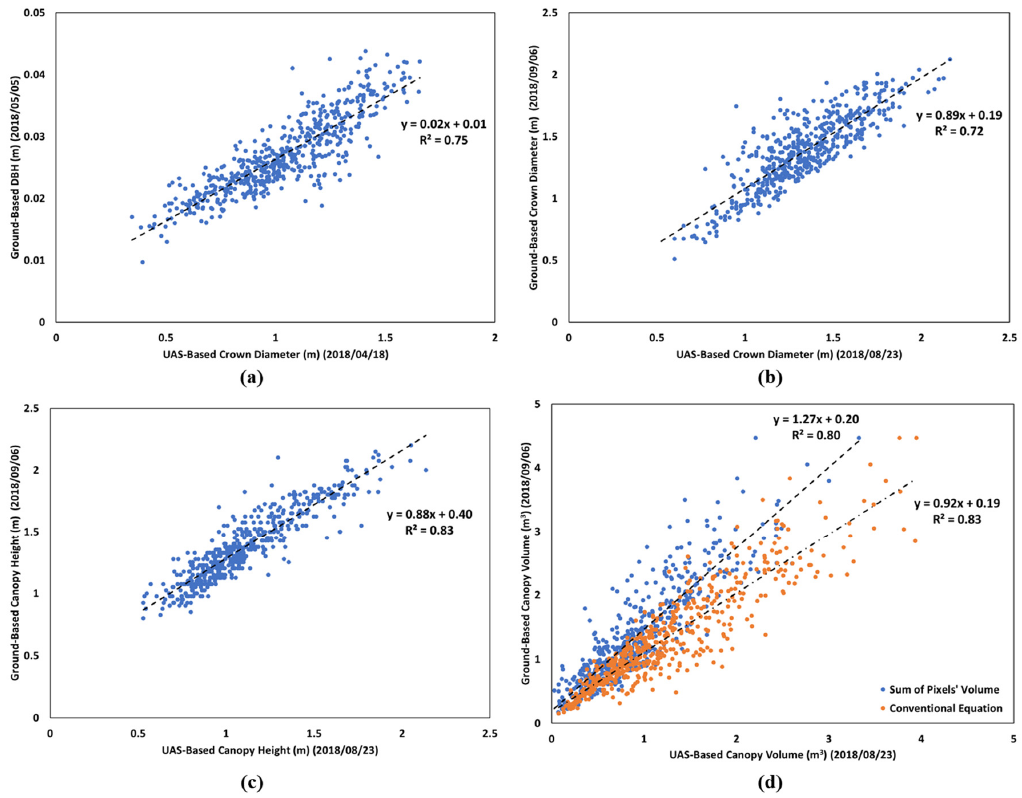
Figure 5. Relationship between the ( a ) ground diameter at breast height (DBH) vs. UAV crown diameter, ( b ) ground crown diameter vs. UAV crown diameter, ( c ) ground tree height vs. UAV tree height, and ( d ) ground canopy volume vs. UAV canopy volume.